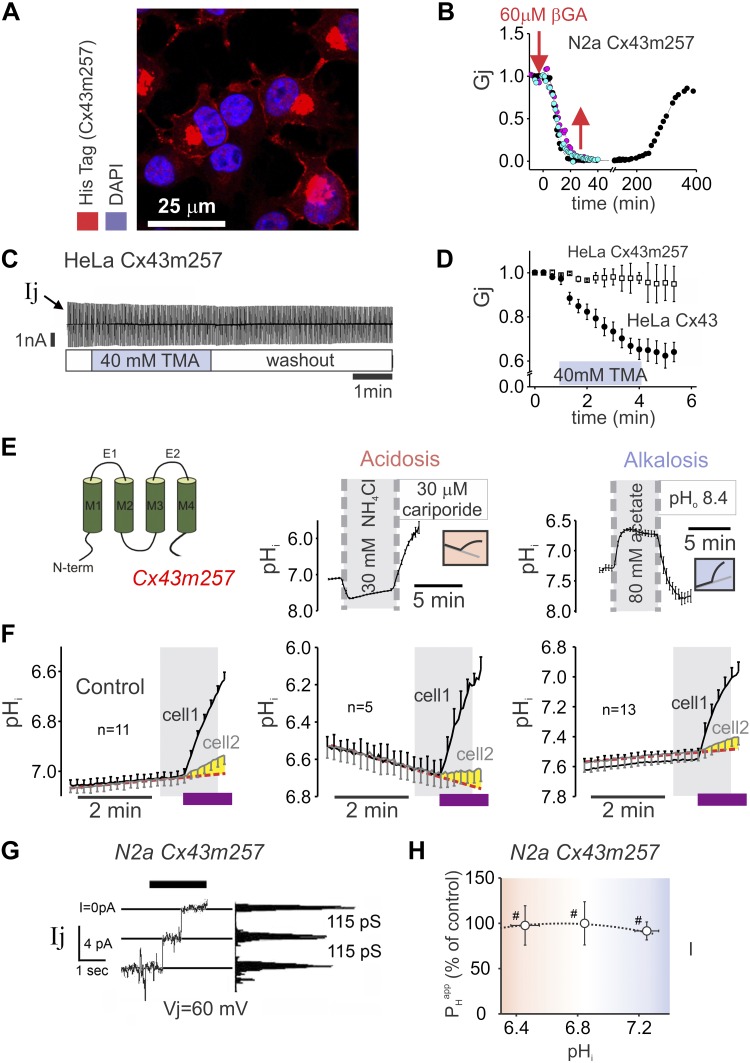
Role of Cx43 C-tail domain in pHi gating. A) Confocal image showing the expression of truncated Cx43 (Cx43m257) tagged with a His-tag domain at the end of the C terminus (red). DAPI staining identified nuclei (blue). B) N2a cells expressing truncated Cx43 become uncoupled after the application of 60 μM βGA (2 separate experiments in red and blue). The effect was reversible (black). C) Junctional current (Ij) does not change during 40 mM TMA perfusion during the application of voltage pulses shown in Fig. 1B. D) Gj in HeLa cells expressing Cx43m257 (n = 3) or wild-type Cx43 (n = 12) during superfusion with 40 mM TMA. E) Cartoon representation of Cx43m257 protein, highlighting the lack of C tail (left). Resting pHi was preadjusted to acidic level before H+ uncaging by 30 mM NH4Cl prepulse returned to normal Tyrode that contained 30 µM dimethylamiloride to inhibit pHi recovery (middle). Resting pHi was preadjusted to the alkaline level before H+ uncaging by 80 mM acetate prepulse returned to normal Tyrode pH 8.4 to slow pHi recovery (right). F) Transmission of acid indicates the persistence of Cx43m257 permeation during acidosis (middle) or alkalosis (right) at levels that were comparable to wild-type Cx43 near resting pHi (left). G) Single channel events recorded from N2a-Cx43m257 cells in 2 mM halothane show open conductance that is similar to wild-type channels. H) PHapp data compiled from all experiments indicate a lack of sensitivity to acidosis or alkalosis of the tailless mutant (from left to right: n = 11, 5, 13). #Significantly different from 0.